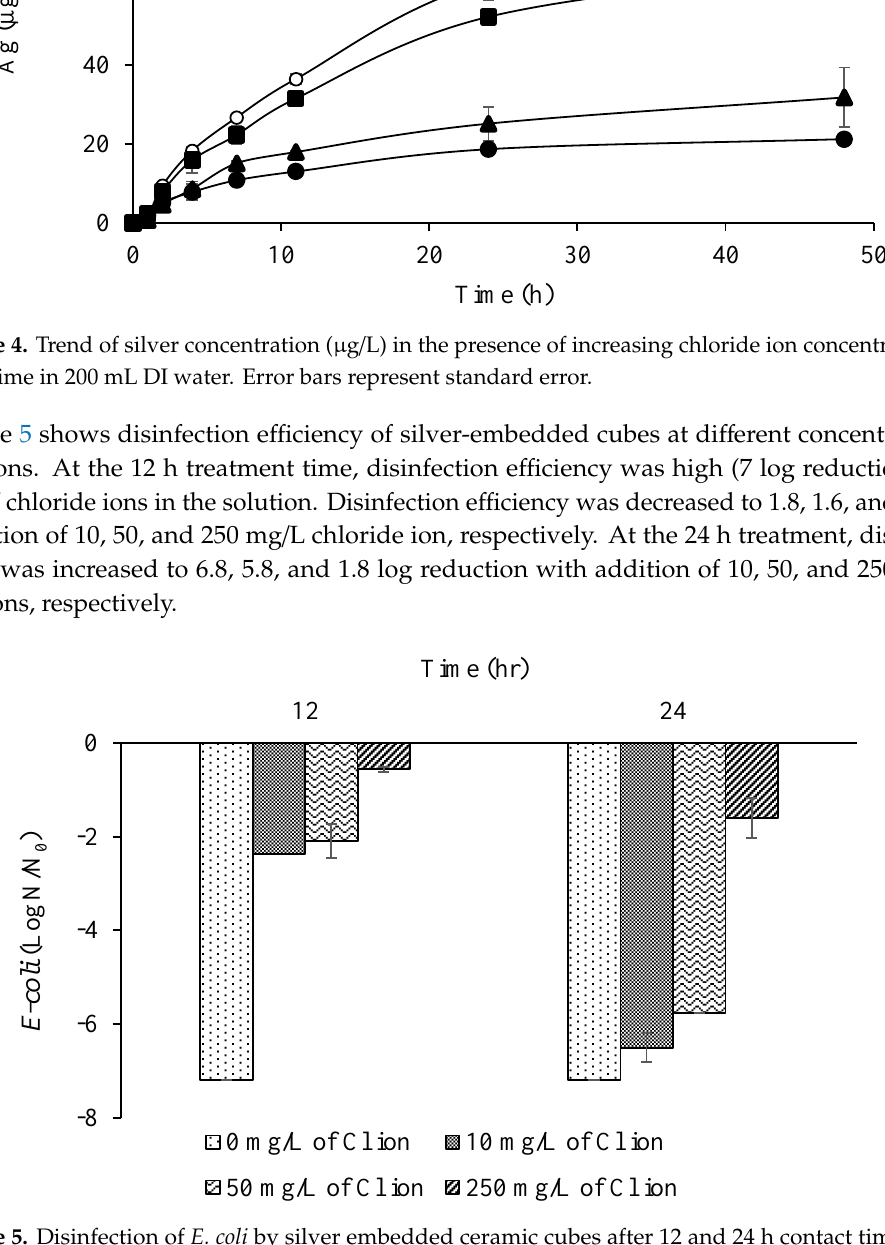
Figure 5. Disinfection of E. coli by silver embedded ceramic cubes after 12 and 24 h contact times in 200 mL DI water. Error bars represent standard error.